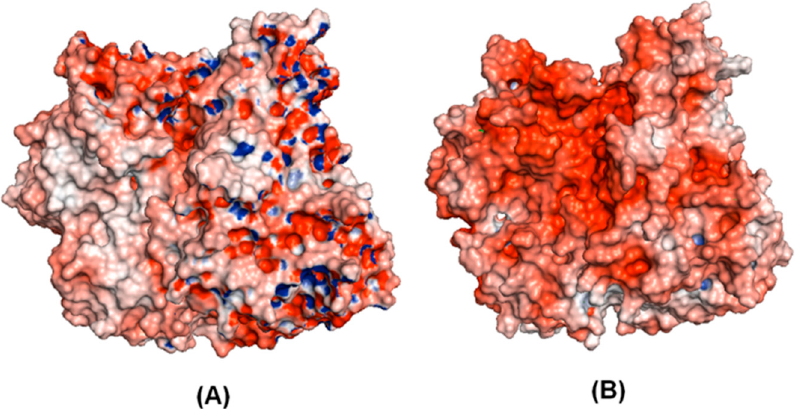
Figure 4. Electrostatic potential density surface obtained by Adaptive Poisson-Boltzmann Solver (APBS): template ( A ) and target ( B